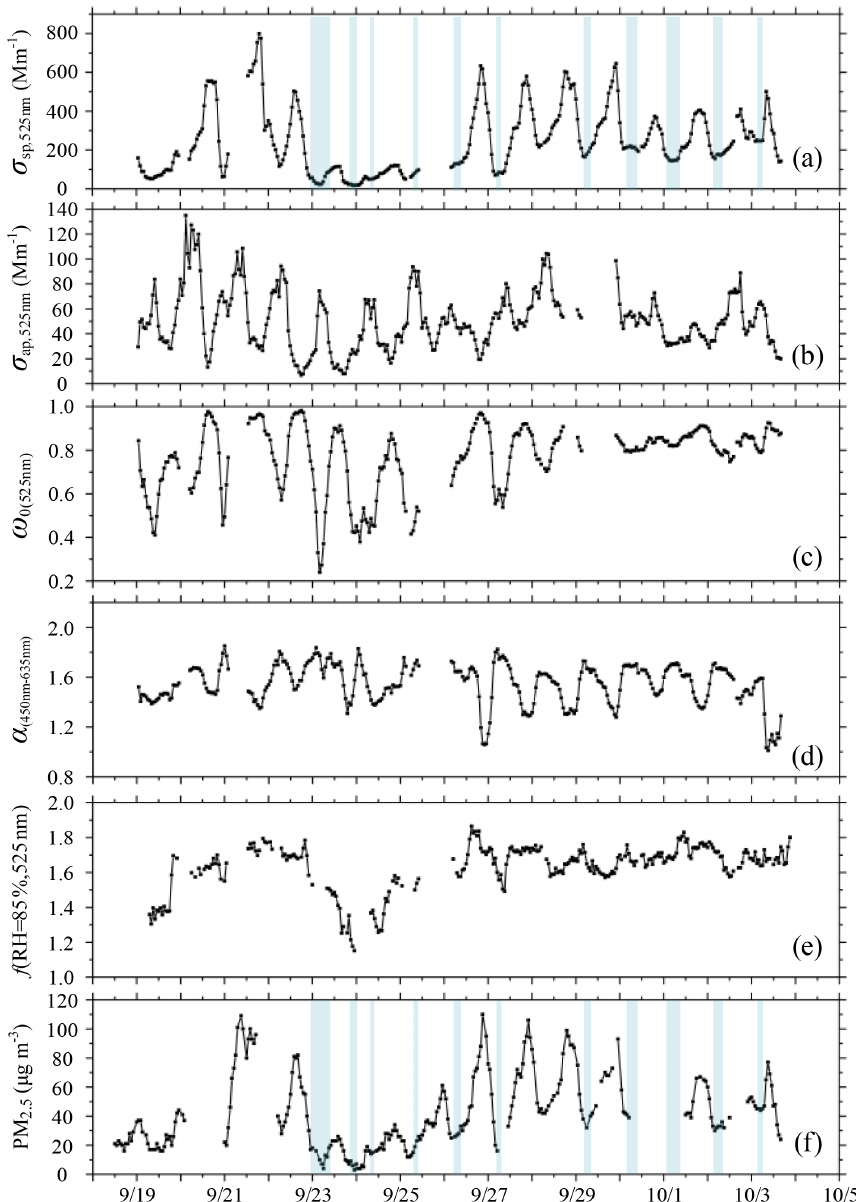
Figure 1. Hourly averaged time series (18 September to 4 October 2019) of the (a) scattering coefficient ( σ sp , 525nm ) measured by the dry nephelometer (unit: Mm − 1 ), (b) absorption coefficient ( σ ap , 525nm ; unit: Mm − 1 ), (c) single-scattering albedo ( ω 0 ( 525nm ) ), (d) scattering Ångström exponent ( α ( 450 − 635nm ) ), (e) particle light scattering enhancement factor at RH = 85% ( f (RH = 85%, 525nm)), and (f) mass concentration of PM 2 . 5 (unit: µgm − 3 ) measured at the Yizhuang station. The segments of the time series with a blue background